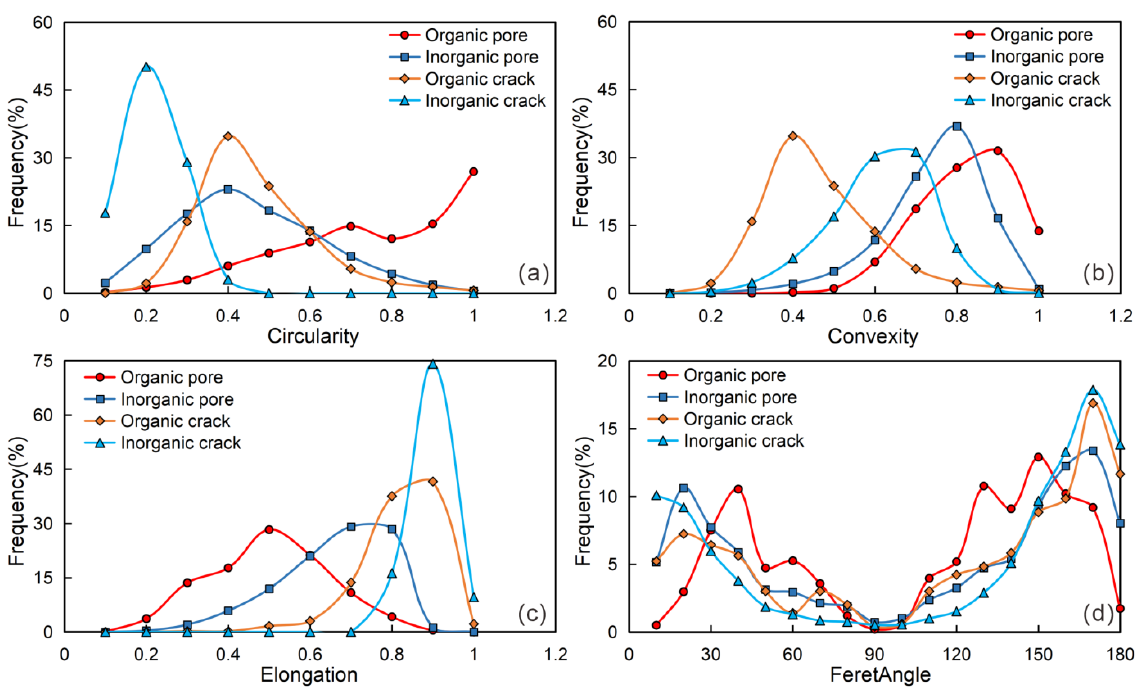
Figure 5. Frequency plots of ( a ) pore circularity, ( b ) pore convexity, ( c ) pore elongation, and Figure5. Frequency plots of (a) pore circularity, (b) pore convexity, (c) pore elongation, and (d) ( d ) pore FeretAngle. pore FeretAngle.